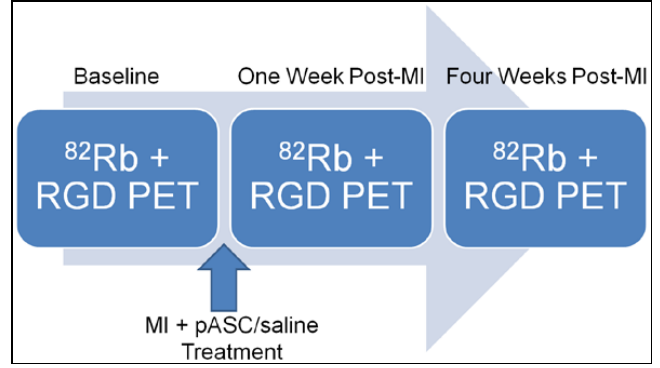
Figure 1. Flowchart showing the time points for 82 Rb and RGD PET scans, MI induction and pASC/saline treatment. Abbreviations: 82 Rb: 82 Rubidium; RGD: 68 Ga-NODAGA-E[c(RGDyK)] 2 ; PET: Positron Emission Tomography; MI: Myocardial infarction; pASC: porcine adipose-derived mesenchymal stromal cell.